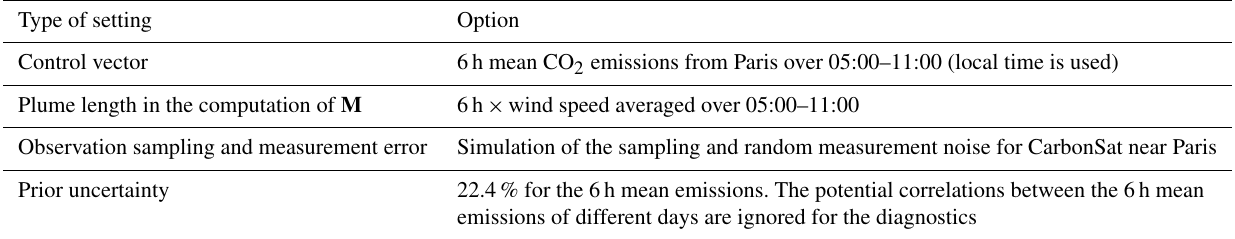
Table 1. The configuration of the PMIF-Paris inversion. Type of setting Option